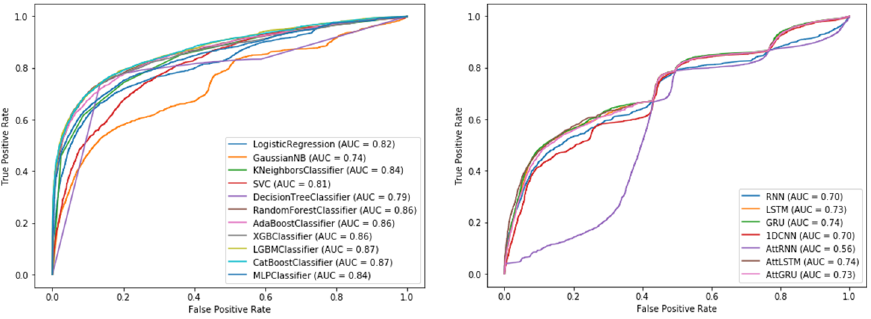
Figure 3. Comparison of the area under the receiver operating characteristic curve (AUROC) for the base model.